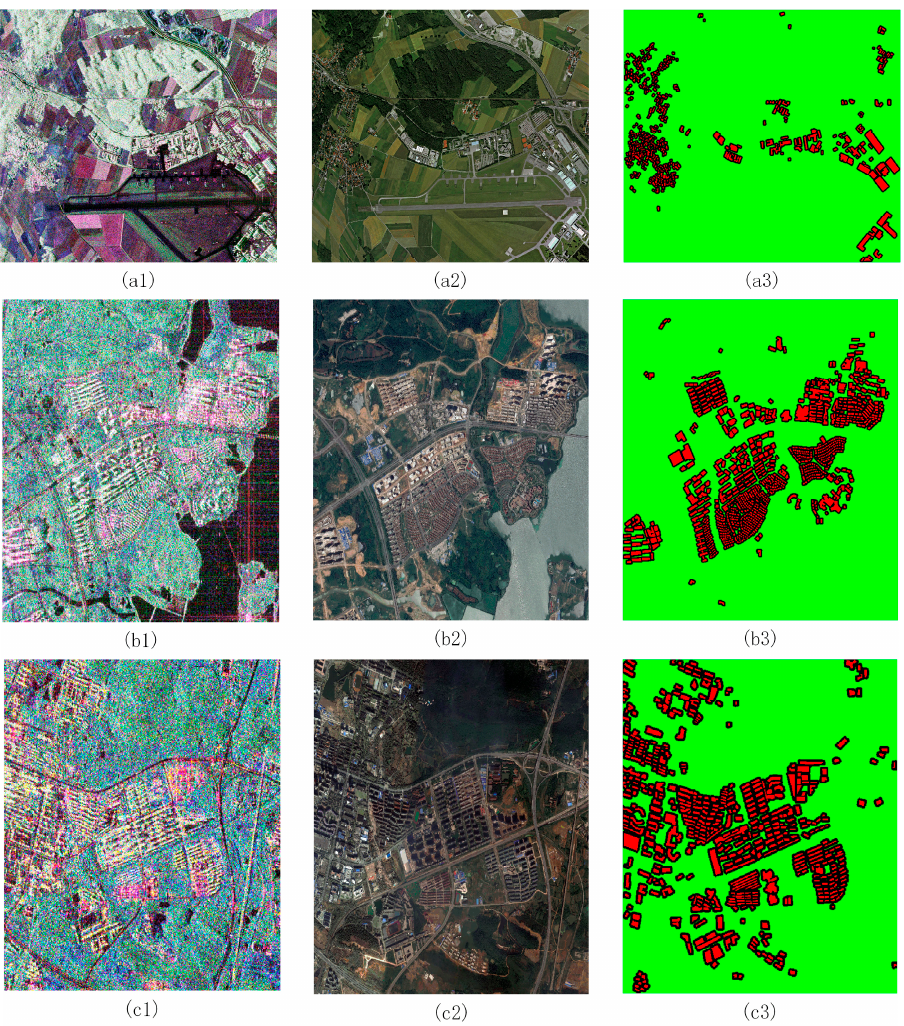
Figure 2. The SAR and optical images, and the true ground map. ( a1 , b1 , c1 ) are the PauliRGB images from E-SAR, GF-3, and RADARSAT-2, respectively. ( a2 , b2 , c2 ) are the optical images. ( a3 , b3 , c3 ) are the true ground map. Red is the building and green is the non-building in ( a3 , b3 , c3 ).